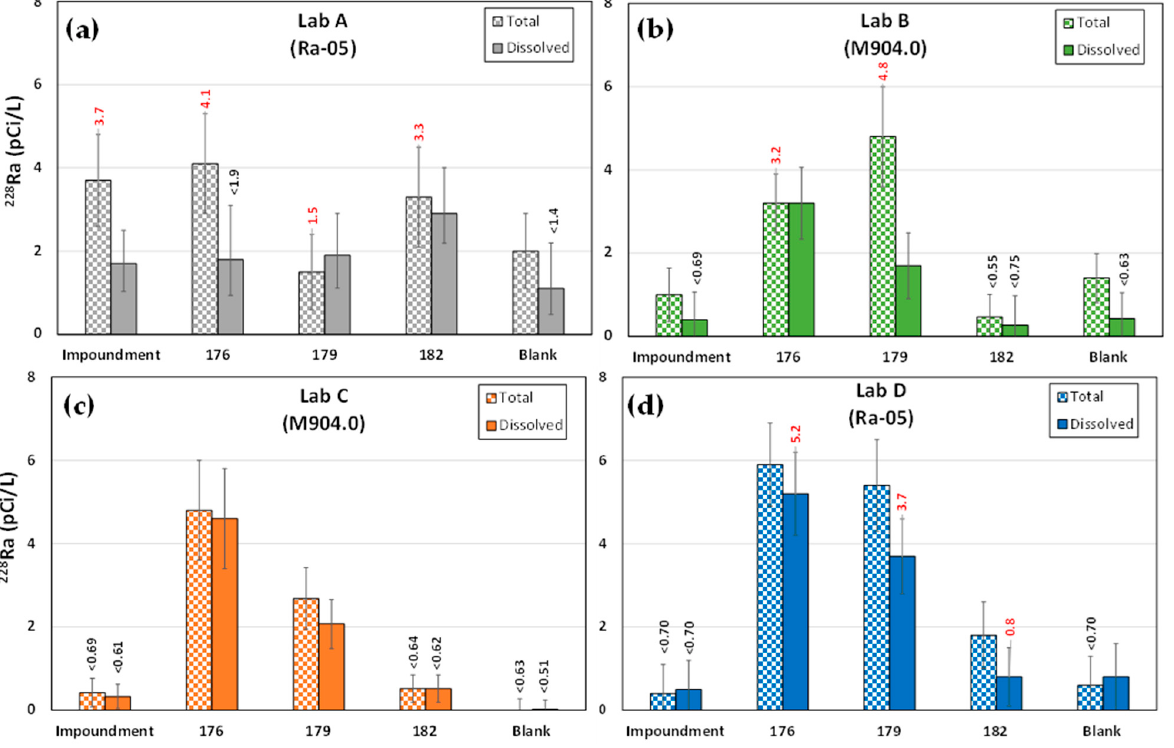
Figure 5. Comparison of total and dissolved 226 Ra concentrations: ( a ) Lab A; ( b ) Lab B; ( c ) Lab C; ( d ) Figure 6. Comparison of total and dissolved 228 Ra concentrations: ( a ) Lab A; ( b ) Lab B; ( c ) Lab C; Lab D. ( d ) Lab